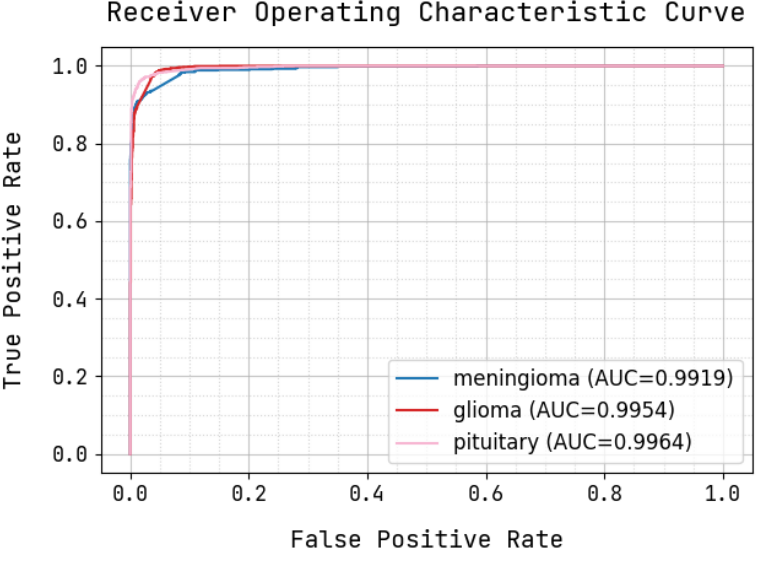
Figure 7. ROC curve correlation.